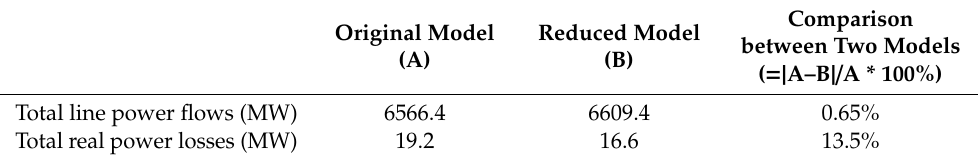
Table 3. Comparison of real power